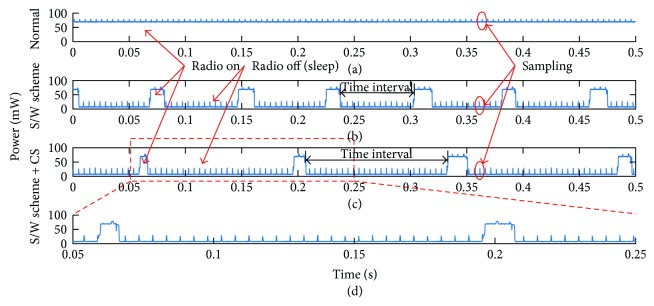
Power traces of the proposed node during different schemes. (a) The normal scheme, no energy saving strategy is used. (b) The S/W scheme. (c) The S/W scheme + CS. (d) The detailed figure of (c). The sampling energy consumption is marked by the red ellipses in (a–c).